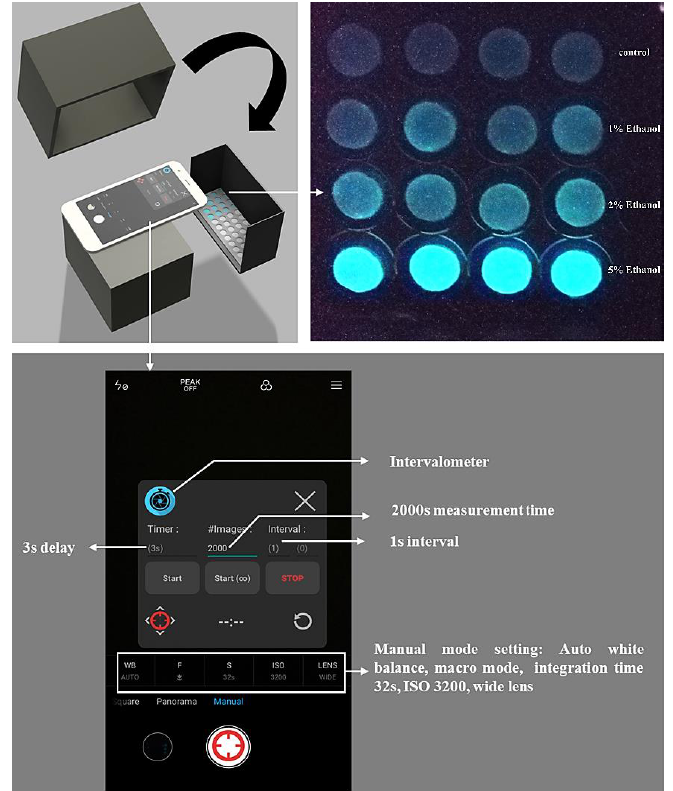
Figure 2. Detailed setup of the smartphone-based whole-cell biosensor.